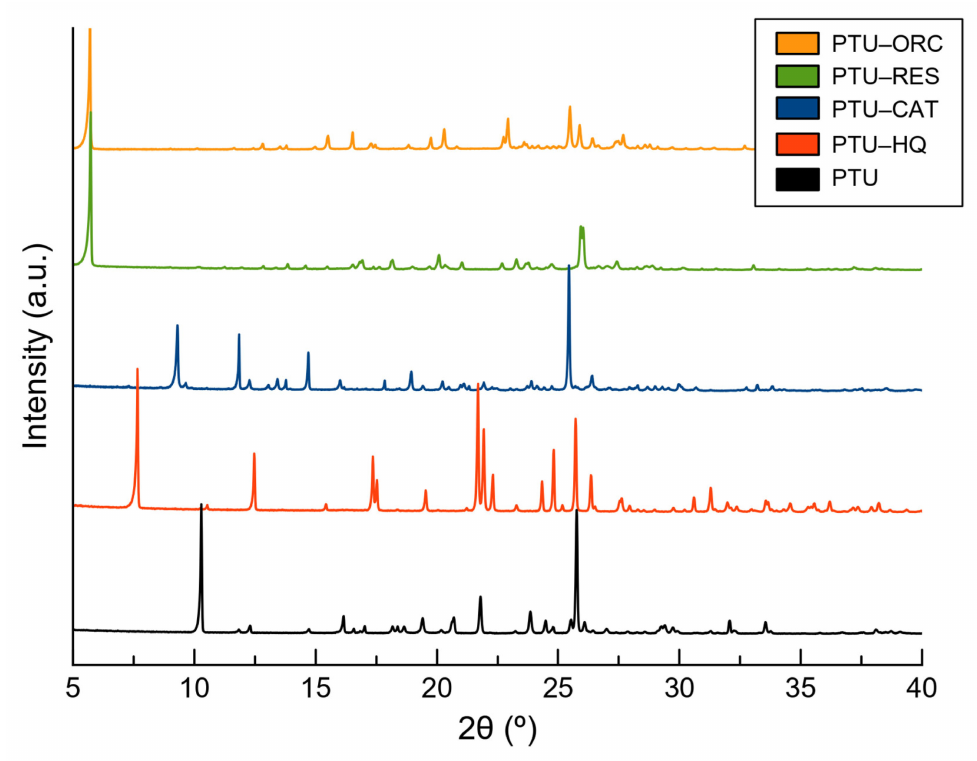
Figure 1. Powder X-ray diffraction (PXRD) patterns of PTU and the new phases obtained by